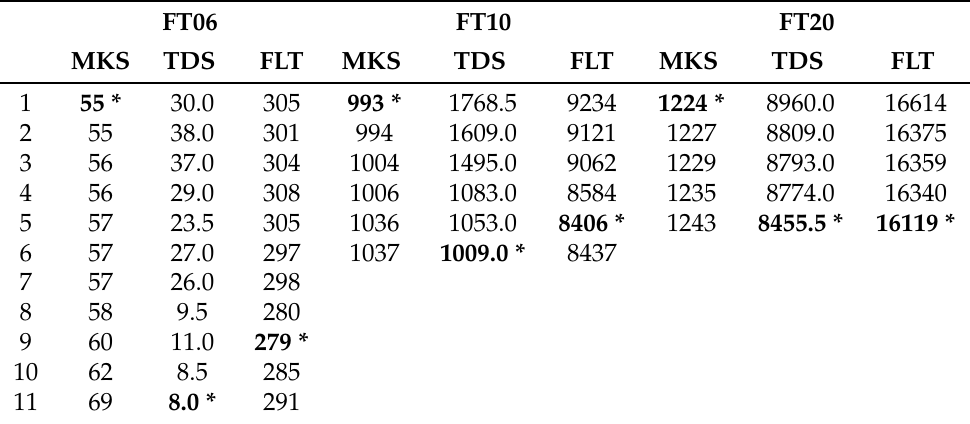
Table A1. Non-dominated front obtained by CMOSA for the JSSP instances proposed by [40].